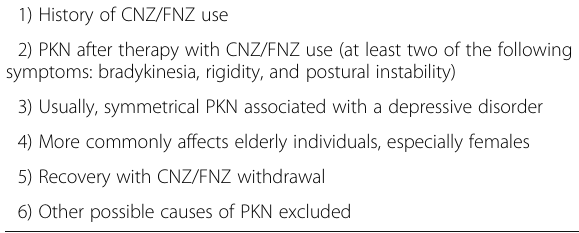
Table 4 Clinical tools for the diagnosis of CNZ/FNZ-induced PKN by Teive et al. [131] modified by Rissardo and